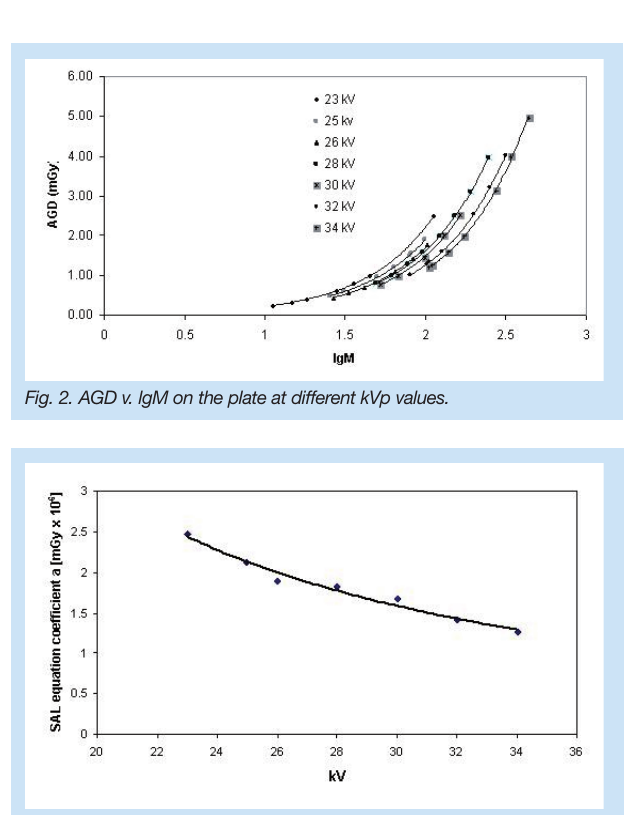
Fig. 3. A plot of the SAL equation coefficient ‘a’ as a function of kV, as indicated in Equation 3 (correlation factor R 2 =0.9763).